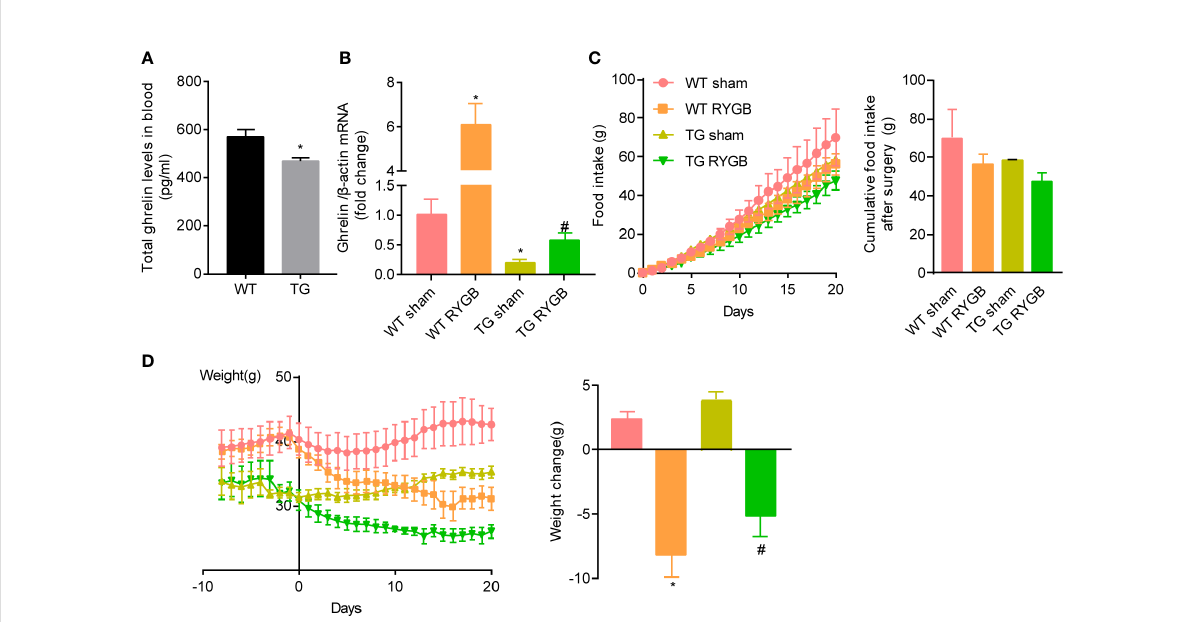
FIGURE 2 Effect of RYGB on food intake and body weight in TG mice with lower ghrelin levels Ghrl-TSC1 -/- (TG) transgenic mice were generated by cross-breeding Ghrl-cre transgenes with TSC1 fl ox/ fl ox mice. Validated TG mice and wild-type littermates (WT) were fed with high fat diet (HFD) for 12 weeks before surgery and 3 weeks after surgery. Results were expressed as mean ± SEM. P values were determined by unpaired t test or one-way ANOVA, followed by Tukey multiple post hoc analysis. *P<0.05 vs. WT Sham. # P < 0.05 vs. TG Sham. (A) Plasma total ghrelin (n=6 and 7 for WT and TG respectively). (B) mRNA levels of gastric Ghrelin in WT or TG mice with sham or RYGB surgery. b -actin was used as internal control (n=4 mice per group). (C) Cumulative food intake. (D) Body weight and weight change after RYGB surgery (n=6 for WT sham, 4 for WT RYGB, 4 for TG sham, and 4 for TG